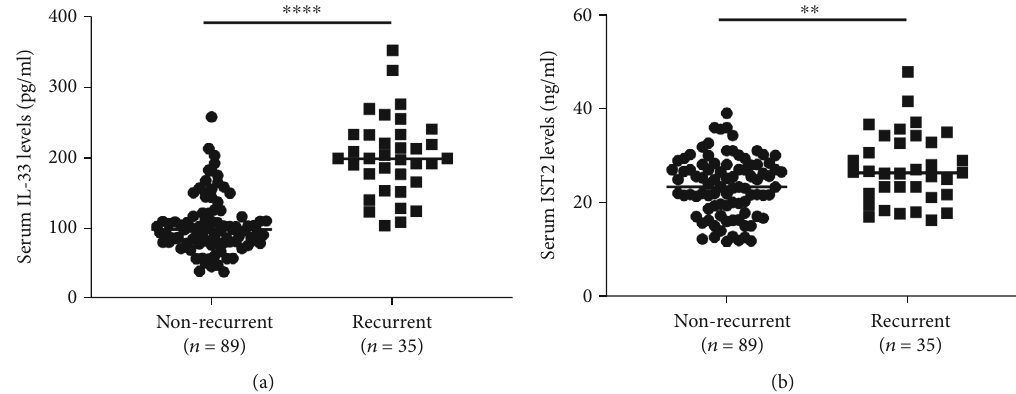
Figure 3: Serum IL-33 and sST2 concentrations were elevated in recurrent CRSwNP patients as compared to nonrecurrent patients. IL-33: interleukin-33; sST2: soluble suppressor of tumorigenicity 2; CRSwNP: chronic rhinosinusitis with nasal polyps; ∗∗ P < 0 : 01 ; ∗∗∗∗ P < 0 : 0001 . Table 6: Unadjusted and adjusted multivariate logistic regression analysis of risk factors associated with CRSwNP recurrence. Factor